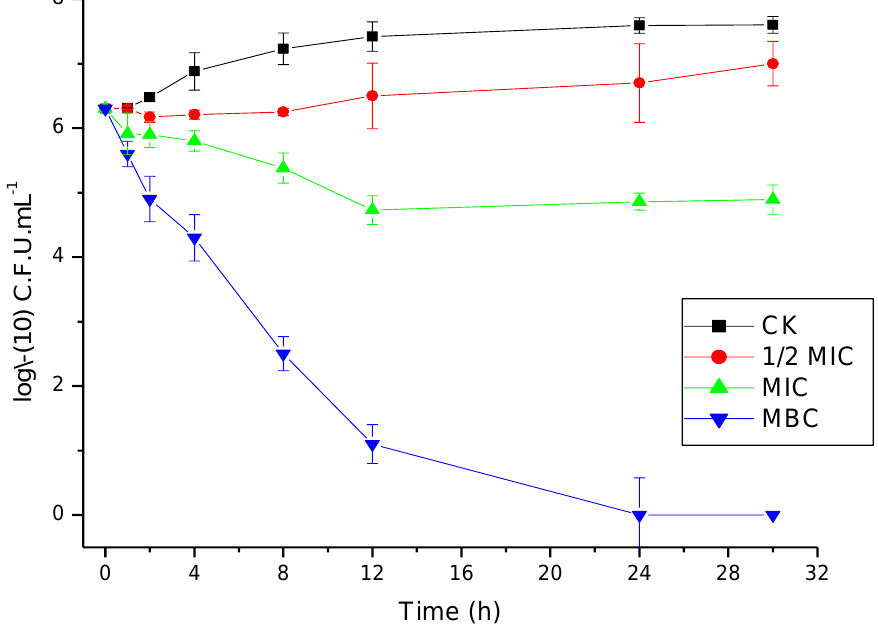
Figure 1. Time − kill assay of essential oil to Saccharomyces cerevisiae at concentrations of 0% v / v (CK), 0.16% v / v (1/2MIC), 0.32% v / v (MIC), and 0.64% v / v (MFC) and the control. Data represent the mean of three independent experiments ± sd. Table 4. Antimicrobial activities of Allium tenuissimum L. flowers essential oil against the tested microorganisms under different pH values.